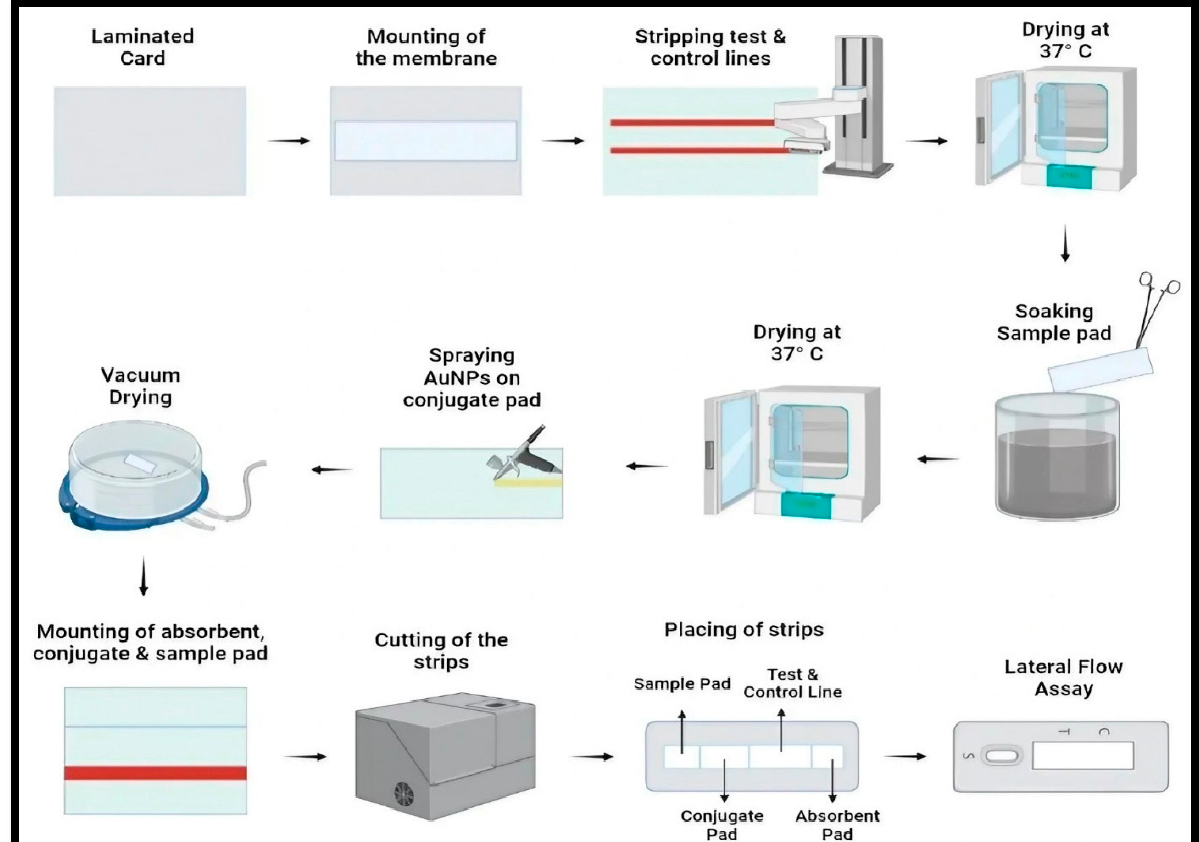
Figure 1. Step-by-step protocol of LFA engineering. Beginning with a laminated card, Mounting of membranes; stripping test and control line settings; Drying at thirty degree Celsius; vacuum drying; Spraying of gold nano-particles on conjugate pad; Drying again; Soaking sample pad; Mounting of absorbent, conjugate, and sample pads; strip cutting; strip placing inside plastic cover; LFA ready (adopted)